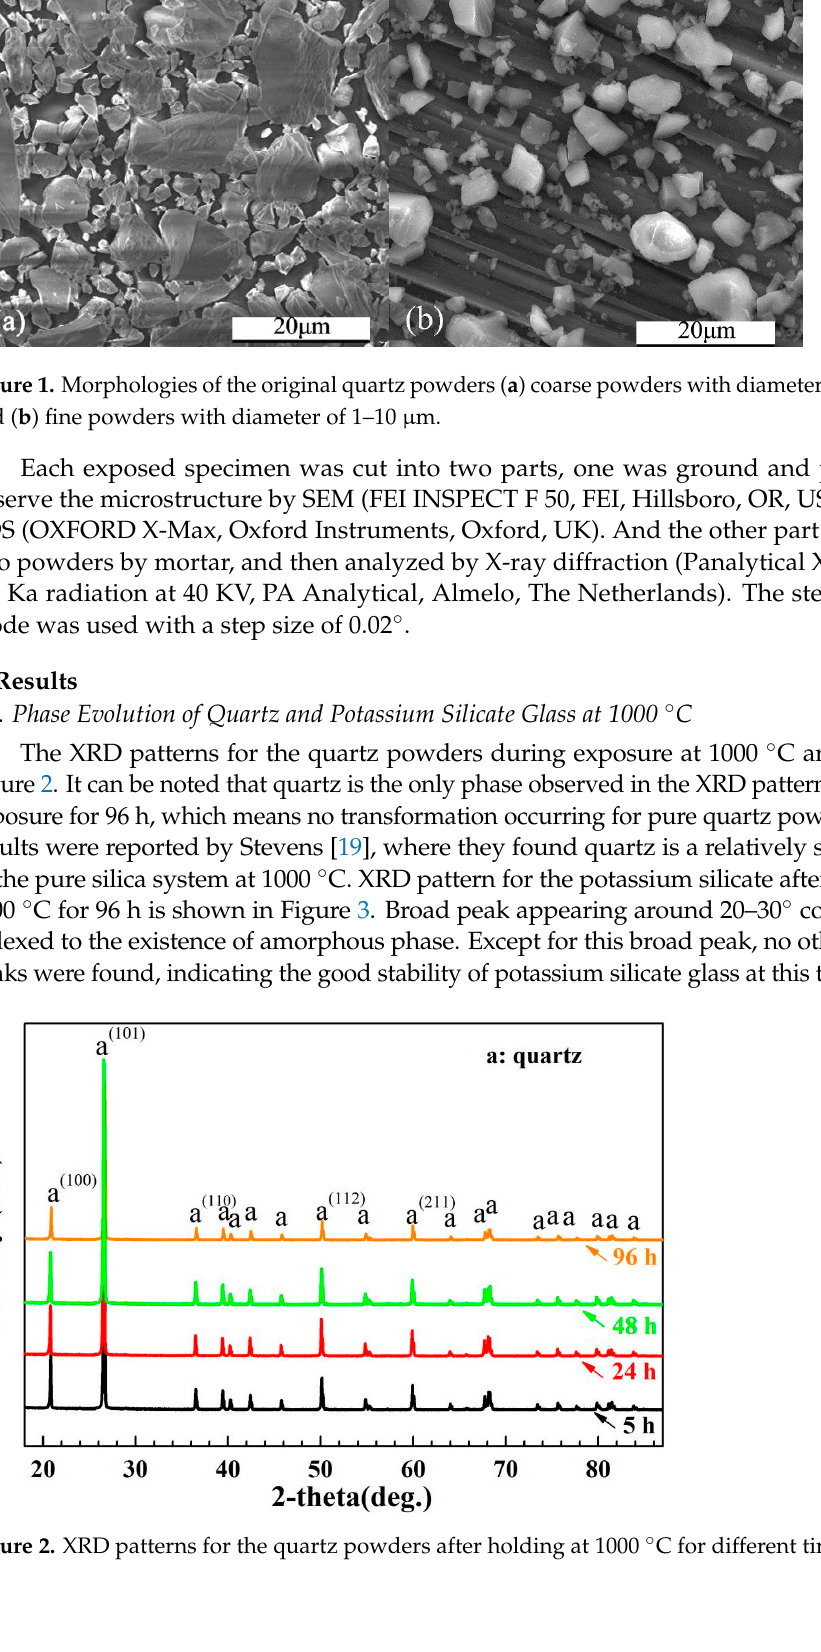
Figure 3. XRD pattern for the potassium silicate after holding at 1000 °C for 96 h. 3.2. Phase and Microstructure Evolution of the Coarse Quartz-Potassium Silicate Glass Compo- sites at 1000 °C and 900 °C The XRD patterns of the coarse quartz-potassium silicate glass composite during ex- posure at 1000 °C and the relationship between the relative content of each phase (ana- lyzed by XRD data) and exposure time are shown in Figure 4. With the extension of ex- posing time, the diffraction peaks of quartz became weaker gradually and totally disap- peared after 96 h. The peaks of cristobalite were observed after exposing for 3 h and be- came stronger in the following 2 h. However, the cristobalite started to diminish after ex- posing for 10 h and no peaks of cristobalite could be observed after 48 h. In comparison, the peaks of tridymite appeared after exposing for 5 h and their intensity kept increasing. When the exposure time extended up to 96 h, tridymite was the only crystal in the speci- men.